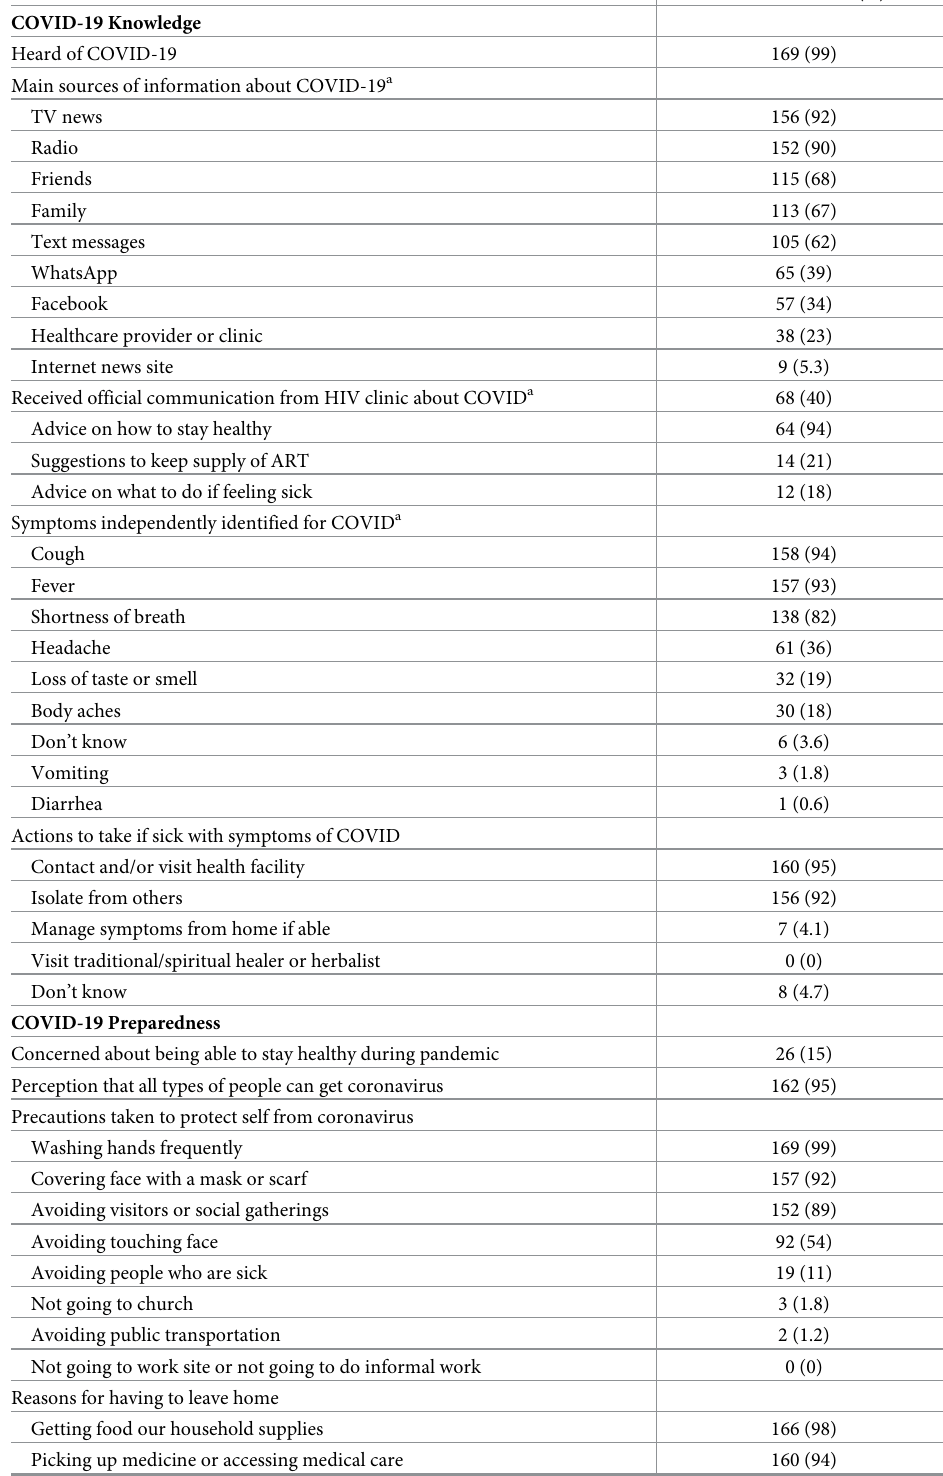
Table 2. COVID-19 knowledge and preparedness among late postpartum